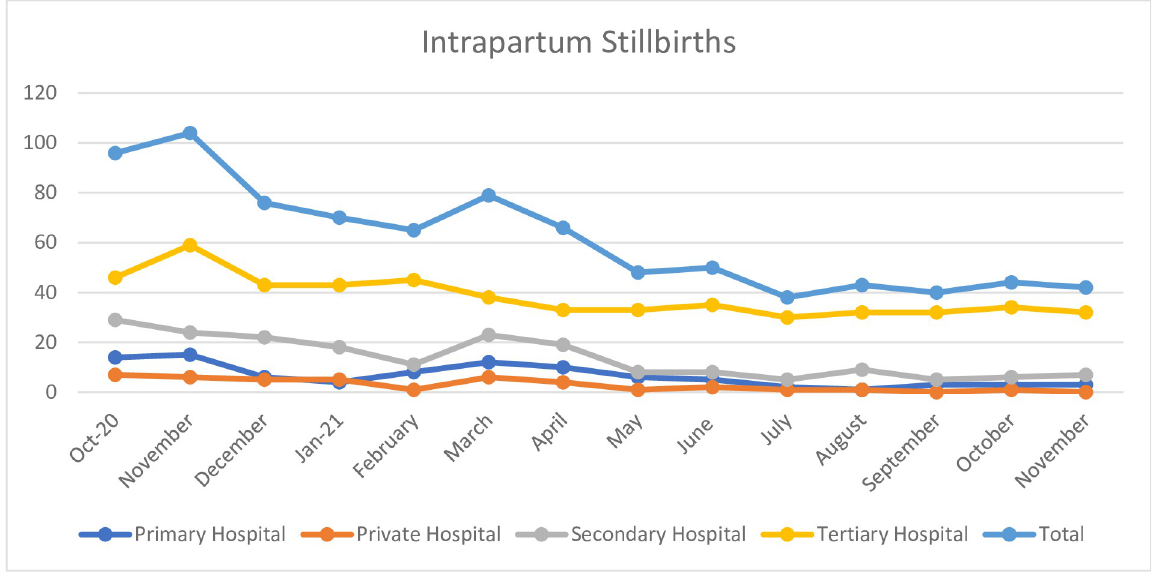
Fig 3. The run chart depicting the association of HBB program with intrapartum still birth over the program period.